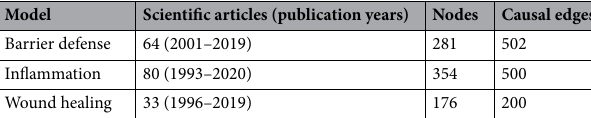
Table 1. Network model